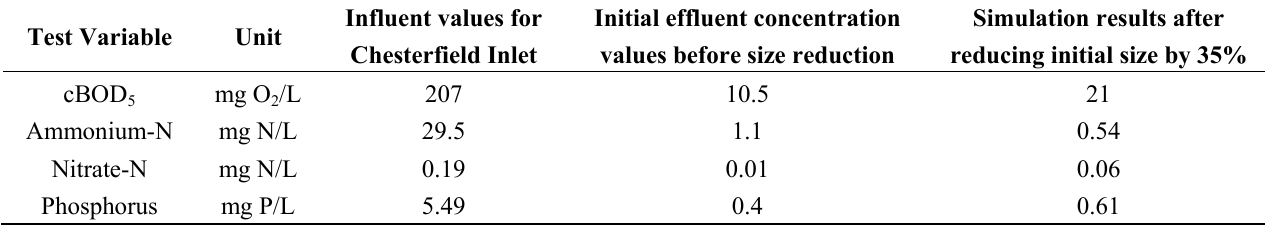
Table 6. Simulated treatment response of the Chesterfield Inlet tundra wetland after reducing the initial size by